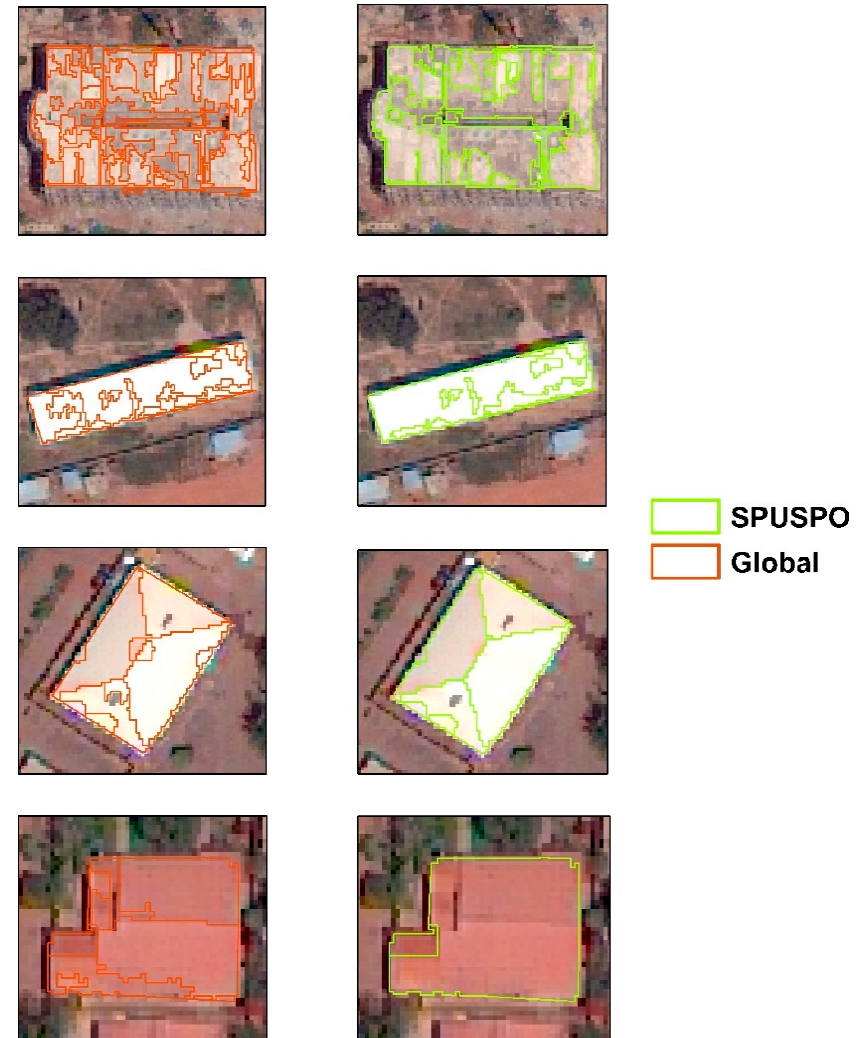
Figure 12. Example segmentations of buildings in Ouagadougou. Red color indicates segments created by a global approach, while green color indicates segments coming from SPUSPO. The decrease of over segmentation is evident in most cases, as the parameters are derived from neighboring locations, better fitting the data structure. Table 3. Area Fit Index for building objects in Ouagadougou. Values closer to 0 suggest a better segmentation, values > 0 imply over segmentation while values < 0 under segmentation.